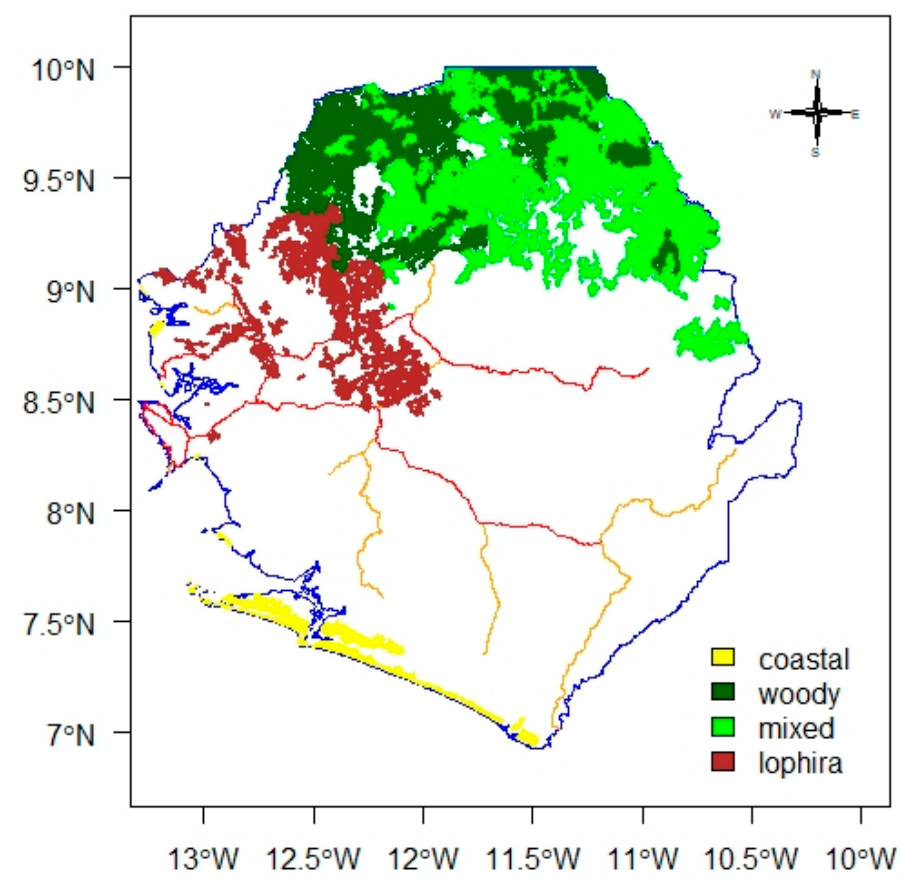
Figure 9. The extent of the savanna woodlands in 1975.